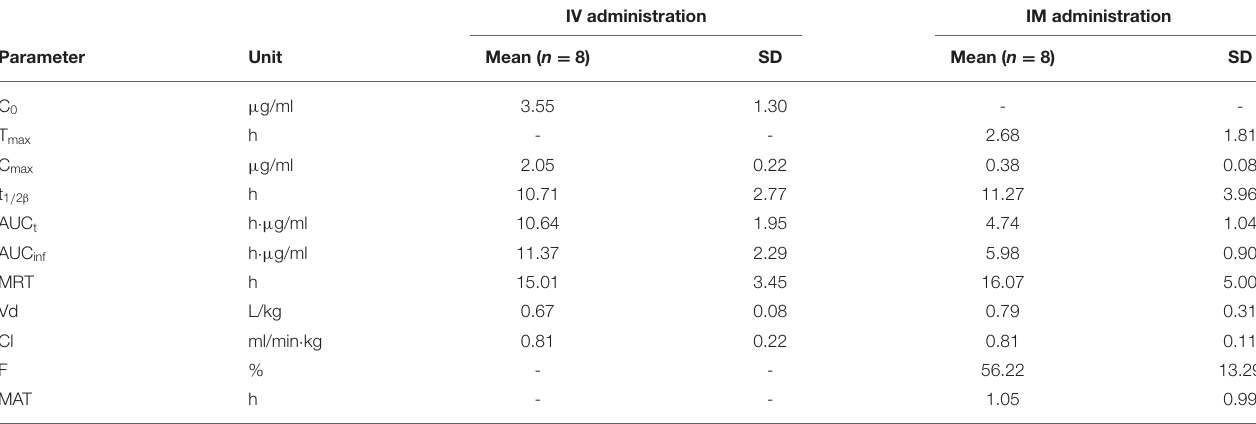
TABLE 1 | Pharmacokinetic parameters of meloxicam administered at a single dose of 0.5 mg/kg IV or IM in nursehounds ( S.stellaris ; n = 8) under human care.